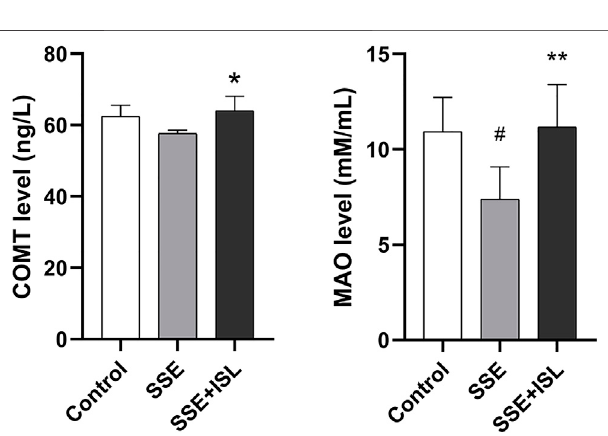
FIGURE 7 | The neurotransmitter metabolic enzyme COMT and MAO were detected by enzyme-linked immunosorbent assay, and one duplicate hole was made. Data are expressed as the mean ± SD ( n (cid:1) 4 – 5). ## p < 0.01, and # p < 0.05 (SSE group vs. Control group); ** p < 0.01, and * p < 0.05 (SSE + ISL group vs. SSE